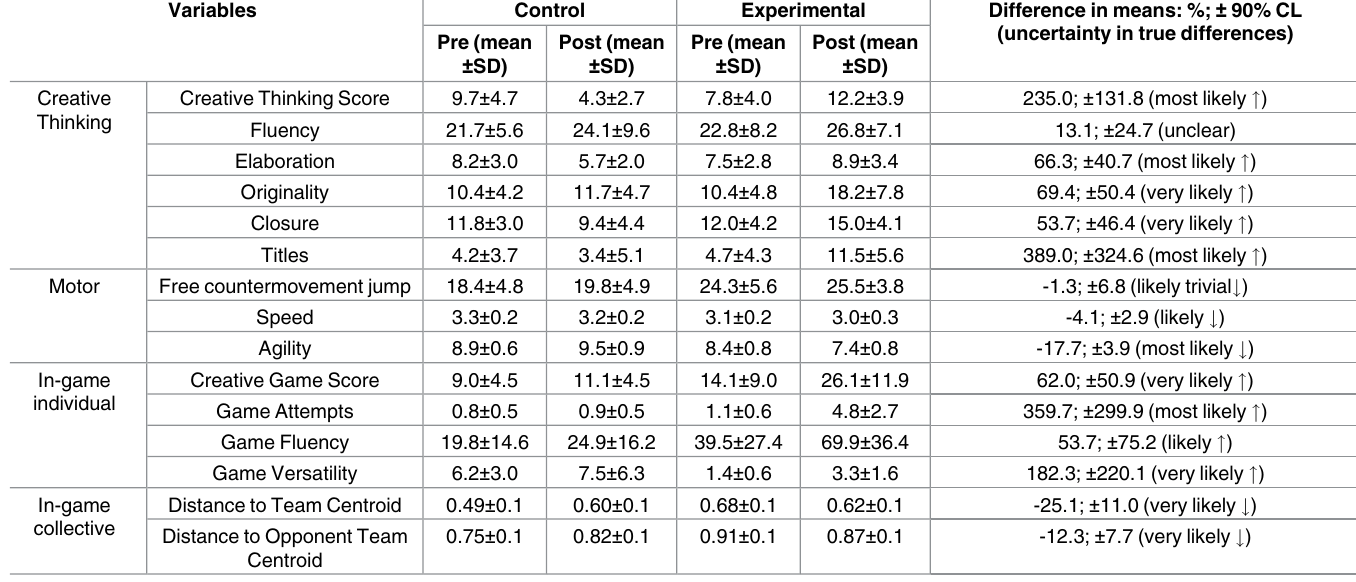
Table 2. Descriptiveanalysis and standardized (Cohen) differences in group means for the Skills4Genius program effectsin thinking, motor and in-game performance between control and experimental